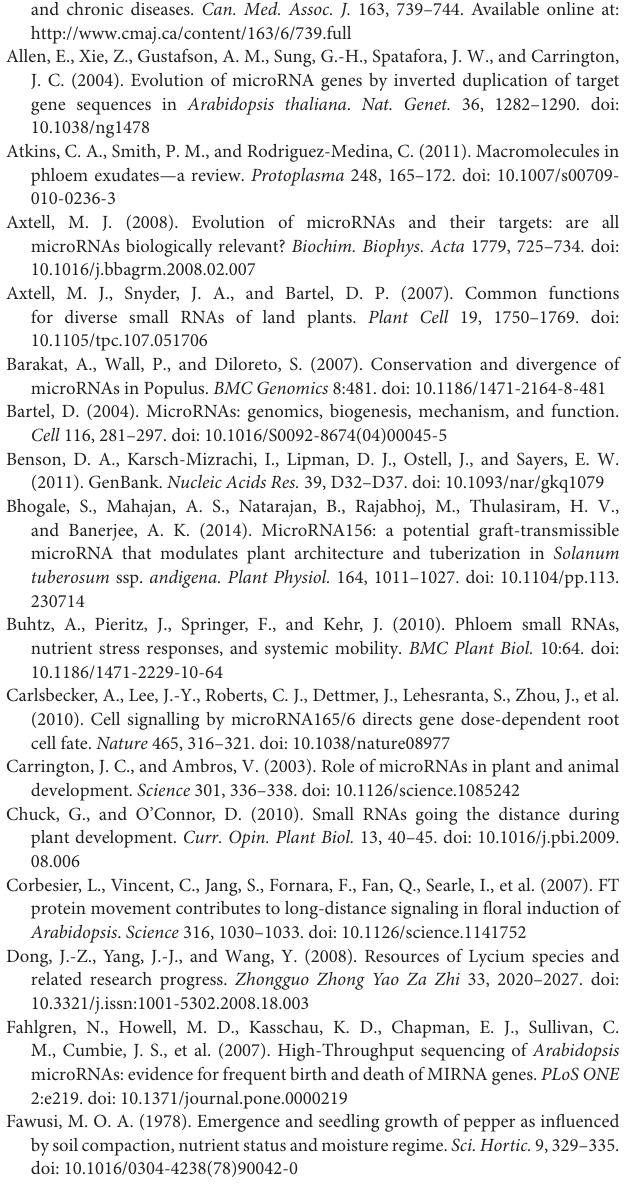
Table S4 | Differentially expressed miRNAs and their corresponding genes in grafted tomato. Table S5 | GO annotation, KEGG enriched pathways and corresponding genes in tomato. Table S6 | The primer designed and candidate list of miRNAs for qRT-PCR with differential expression through deep sequencing. Table S7 | Significantly up-regulated evolutionary known miRNAs with 2.4-, or more fold-change in grafted tomato. Table S8 | Significantly down-regulated evolutionary known miRNAs in grafted